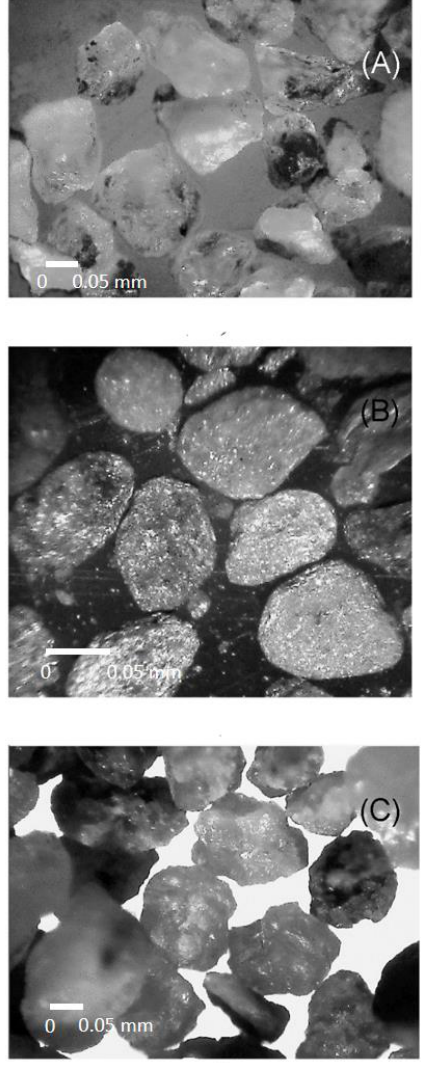
Figure 4. Morphological characteristics of ( A ) quartz, ( B ) slate, and ( C ) other rock fragments by the low-power microscope.